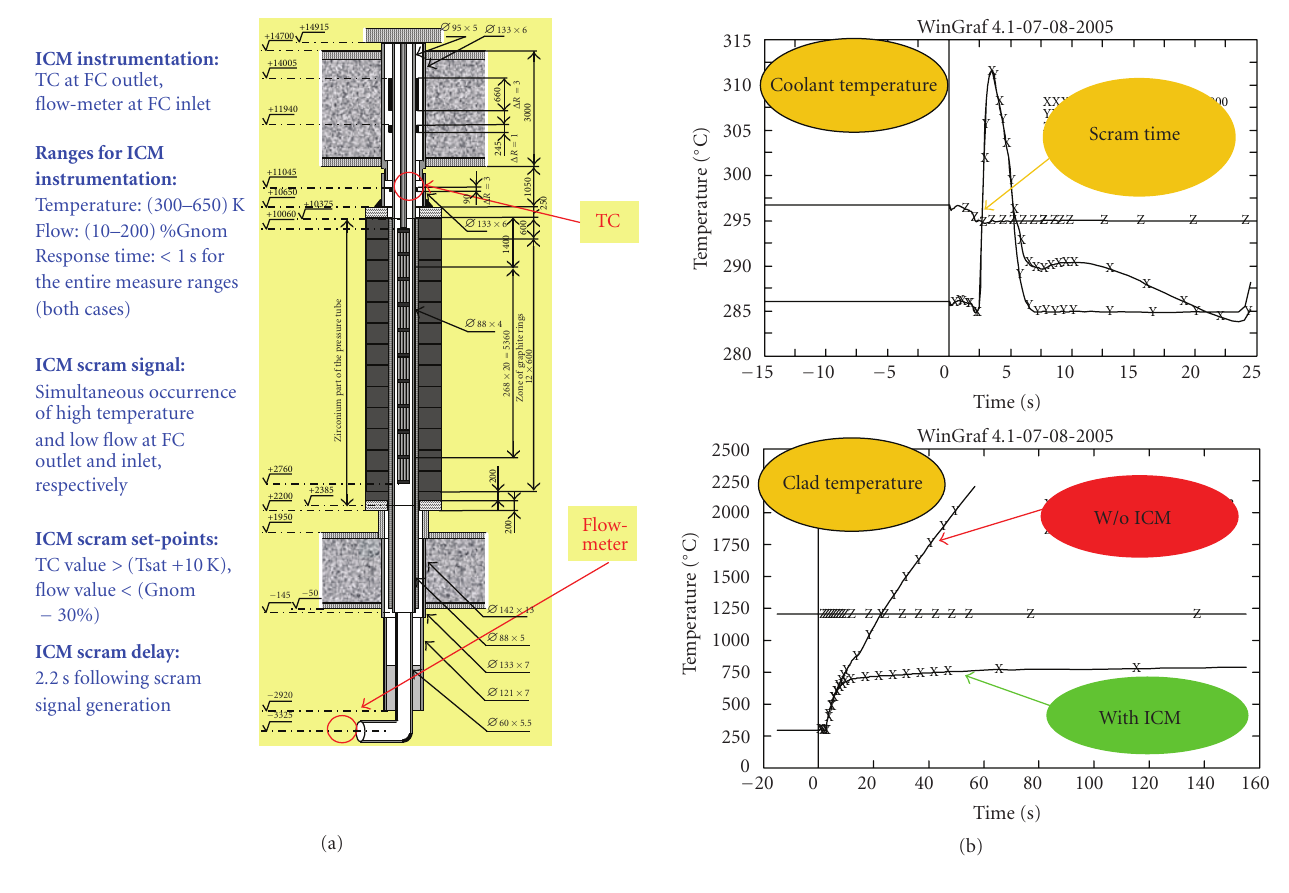
Figure 4: The ICM and the predicted working